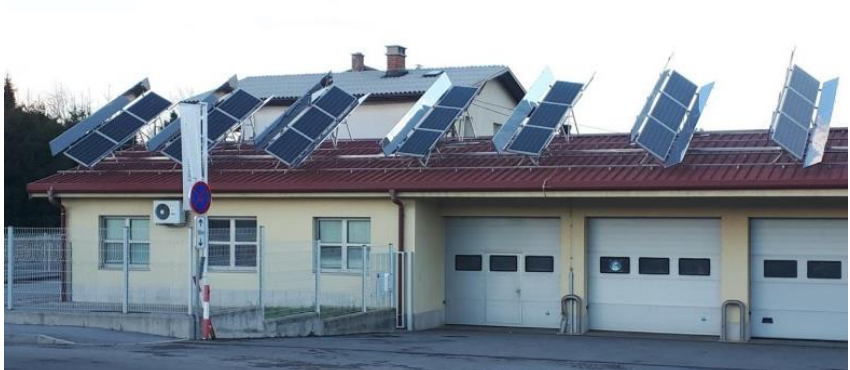
Figure 3. Concentrating PV system in municipality Pivka (Elektro Primorska d.d., Distribution unit Sežana, supervision Pivka - Electricity distribution company).